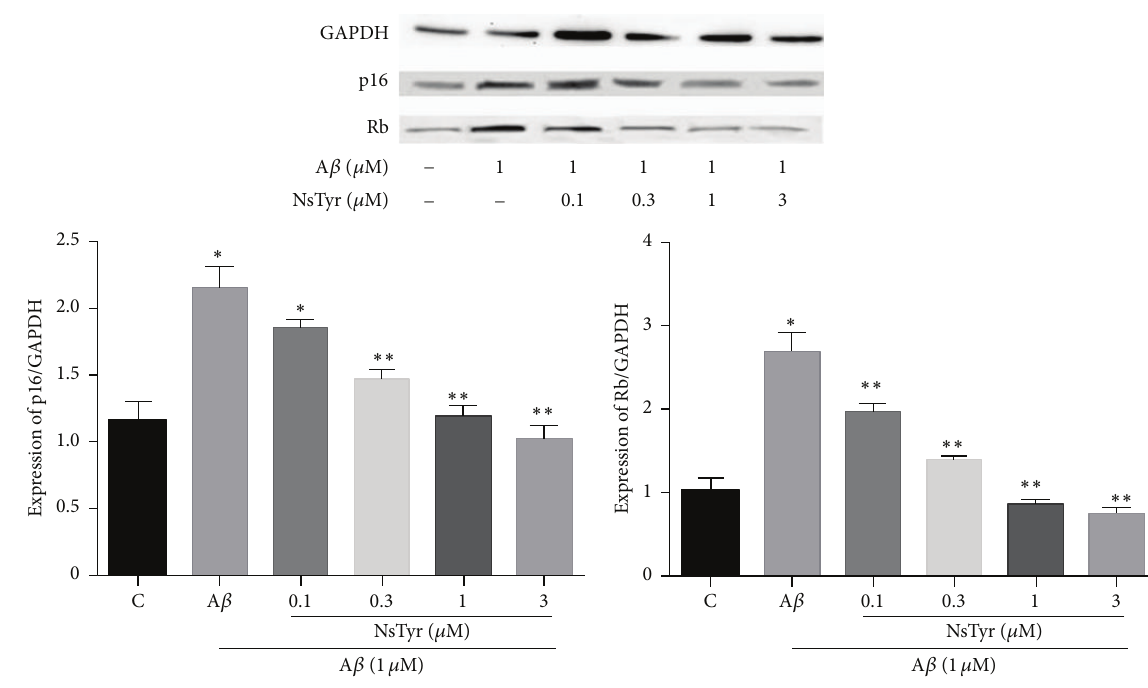
Figure 10: The influence of NsTyr-2K on the expression of Rb1 and p16 in NSPCs which coincubated with A 𝛽 1 , (3) 1 𝜇 M A 𝛽 1 + 0.1 𝜇 M NsTyr-2K, (4) 1 𝜇 M A 𝛽 1 with (1) none, (2) 1 𝜇 M A 𝛽 1 – 42 – 42 + 3 𝜇 M NsTyr-2K. The expression of Rb1 and p16 was detected by WB. ∗ 𝑃 < 0.05 versus control group, ∗∗ 𝑃 < 0.05 versus A 𝛽 1 1 𝜇 M A 𝛽 1 – 42